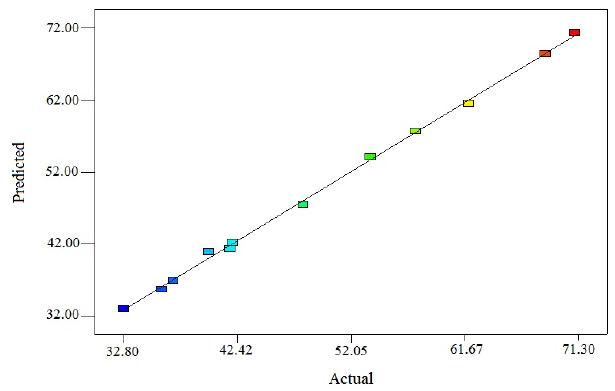
Fig. 14. Predicted versus actual